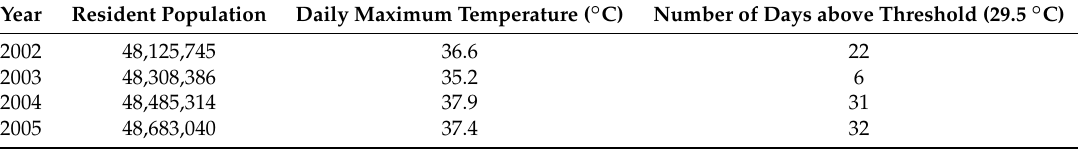
Table A1. Korean Population Change, Maximum Temperature of the Year, and Number of Days above